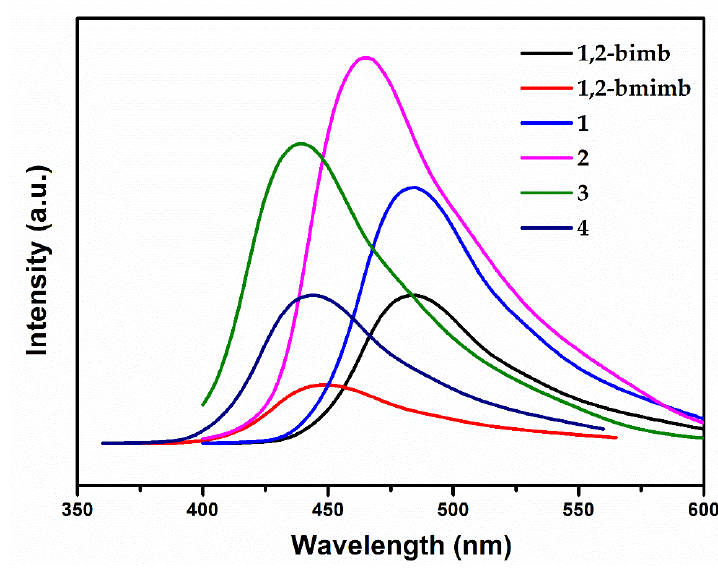
Figure 6. Photoluminescence of free ligand complexes 1 – 4 .